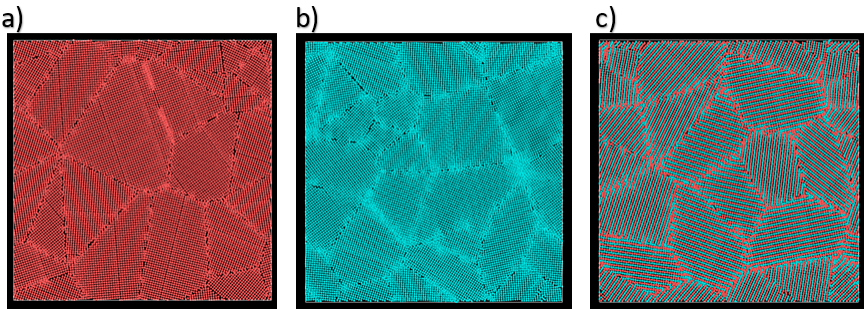
Figure 1. 2D image of the polycrystal structure of ( a ) Cu, ( b ) Ni, and ( c ) equimolar Cu-Ni alloy (the copper atoms are shown by the red color and the nickel atoms are shown b blue color).